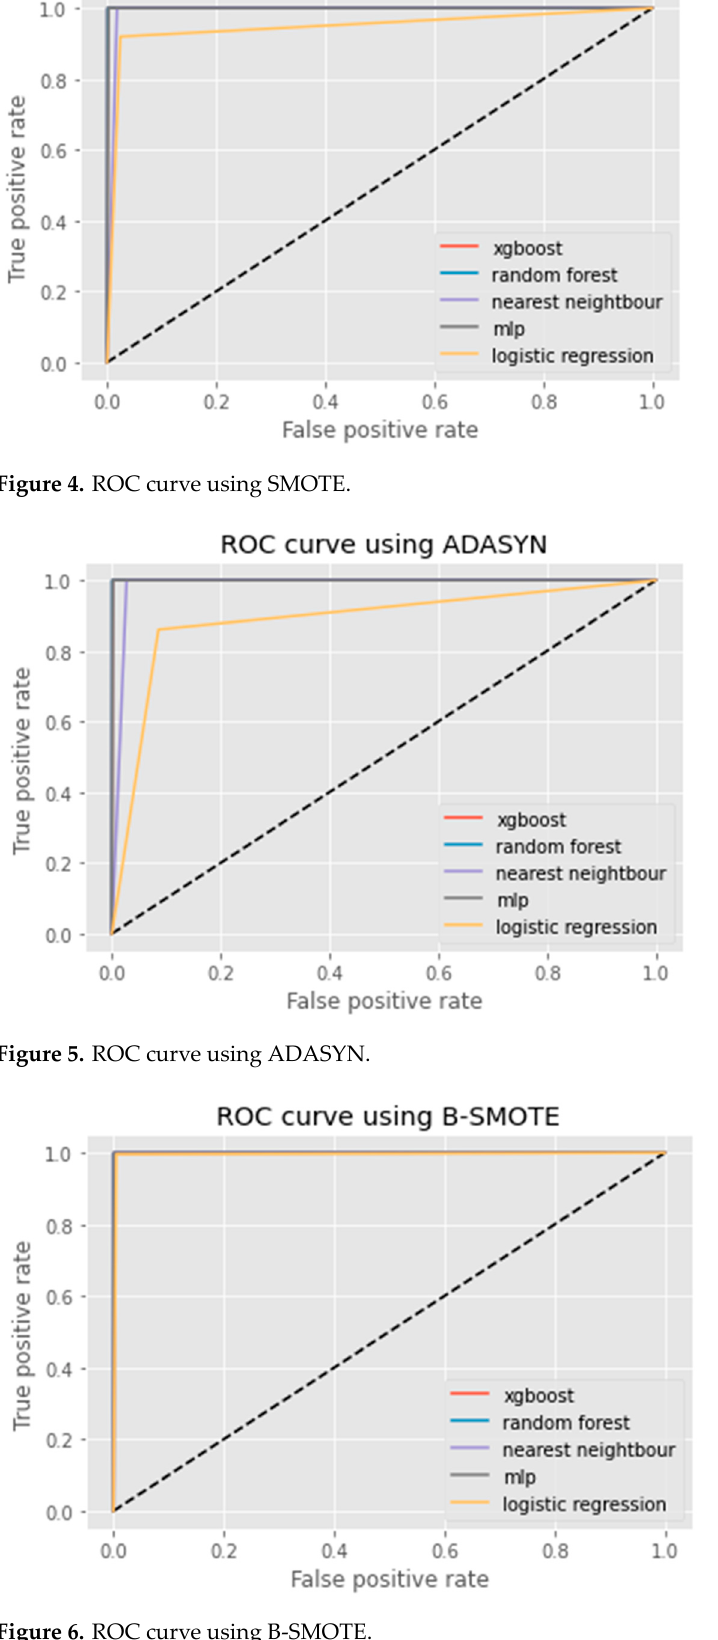
Figure 6. ROC curve using B-SMOTE.